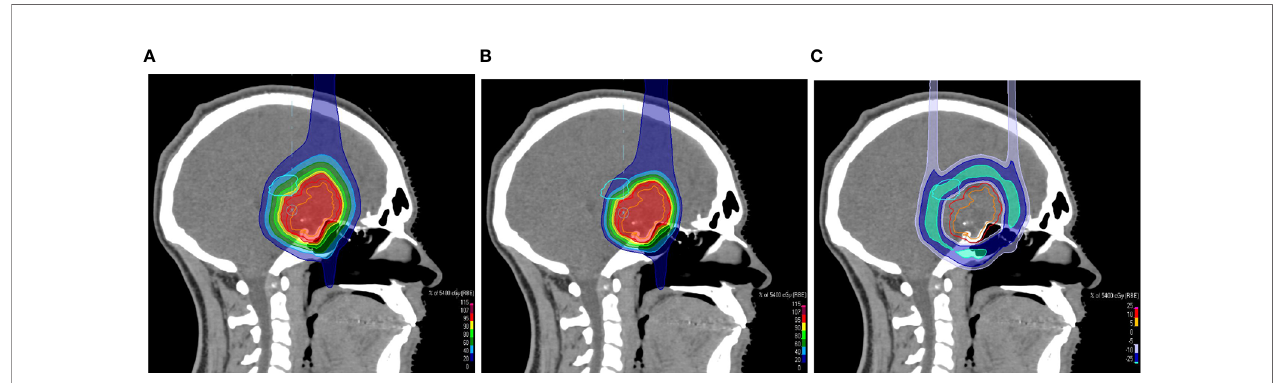
FIGURE 5 | Sagittal CT slices overlaid with a colorwash representation of the dose distribution of the uncollimated plan (A) and the treatment plan with apertures (B) for the treatment of a suprasellar craniopharyngioma. The screenshots of the treatment planning in RayStation show the dose sparing of the left thalamus, which is indicated by the light blue contour. (C) shows the dose difference between the plans.